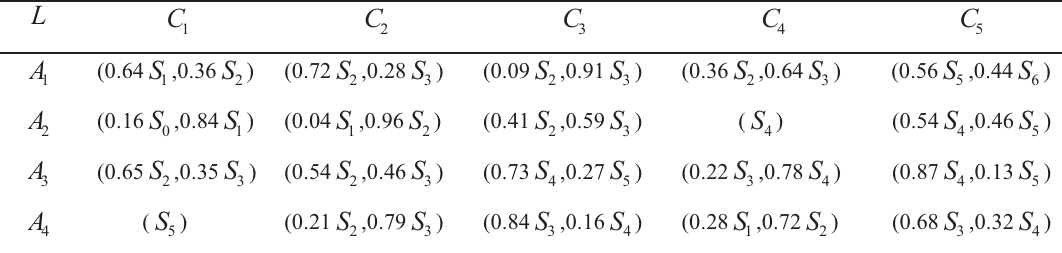
Table 7. The group comprehensive evaluation matrix